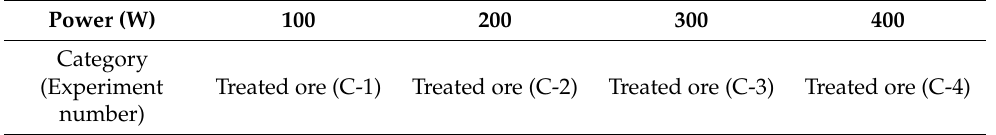
Table 6. Experimental design for the effect of the ultrasonic power desulfurization rate.